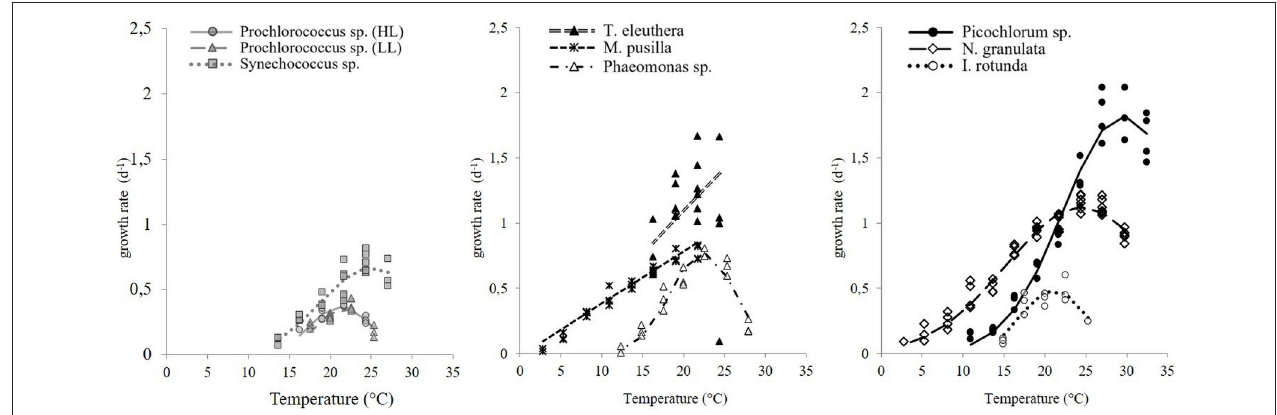
FIGURE 1 | The response of maximum growth rates of picophytoplankton to temperature, including three strains of picoprokaryotes (gray symbols) and six strains of picoeukaryotes (black or white symbols). The lines indicate the best fit chosen by AIC values.